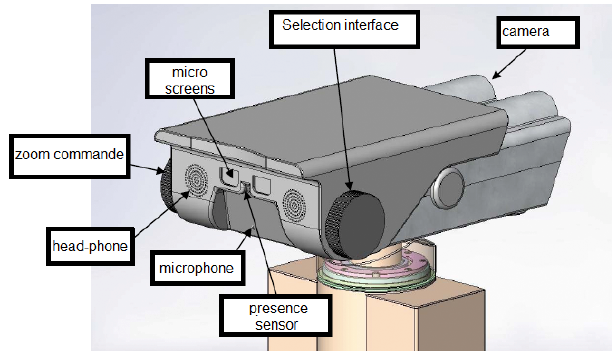
Fig. 3. Mecanical Architecture of the Telescope.